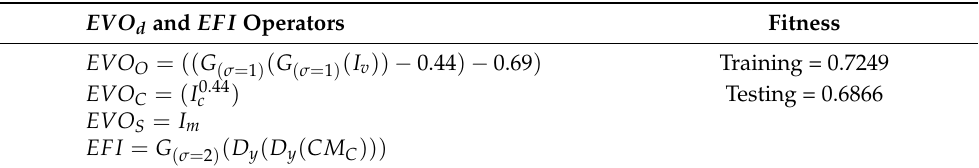
Table 6. Program structure of the operators corresponding to the best solution for the IMGSAL database. We select this solution from the 30 executions of Table 5. The final solution applies filters to selected color images and derivatives to the conspicuity maps.